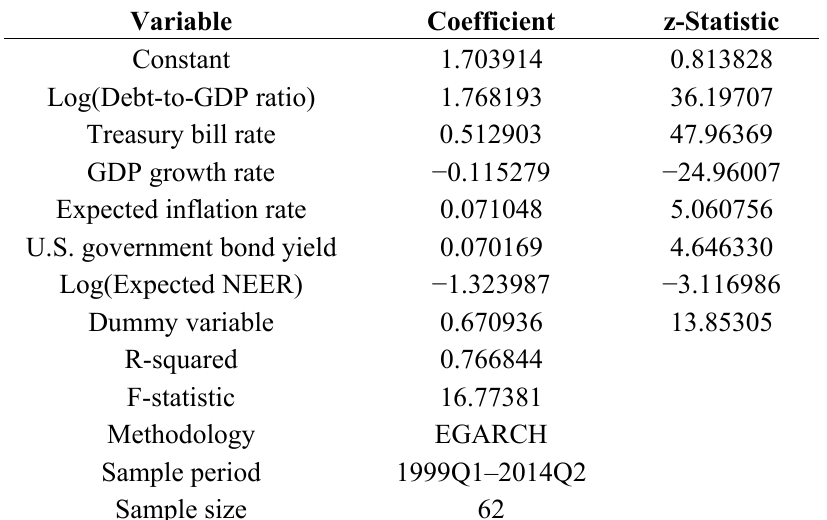
Table 1. Estimated Regression of the Spanish Government Bond